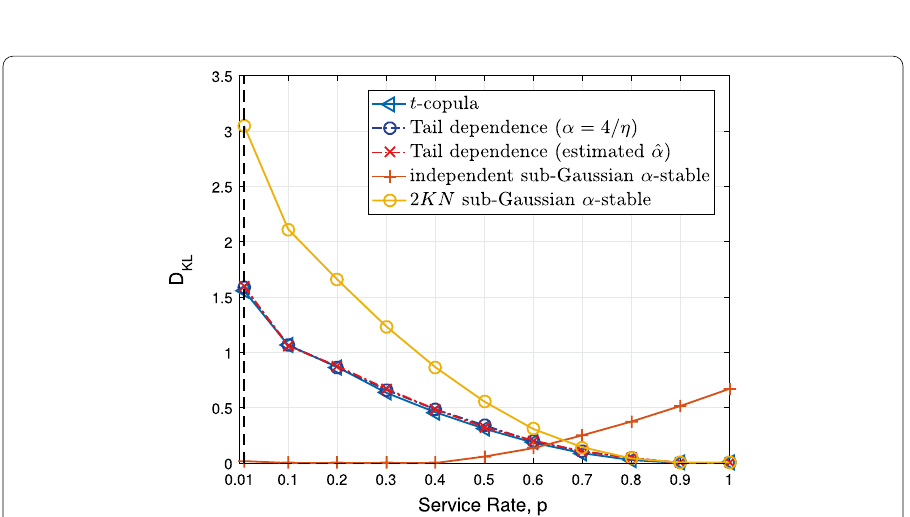
Fig. 7 Plot of the KL divergence between the simulated data set and five statistical models (under Matérn hard‑core process of type II): t ‑copula model (maximum likelihood); Algorithm 1 based on α = 4 /η ; Algorithm 1 based on estimated ˆ α ; independent sub‑Gaussian α ‑stable model; and 4 K sub‑Gaussian α ‑stable model. In the figure, K = 4 msBs and N = 2 subcarriers in each msB are